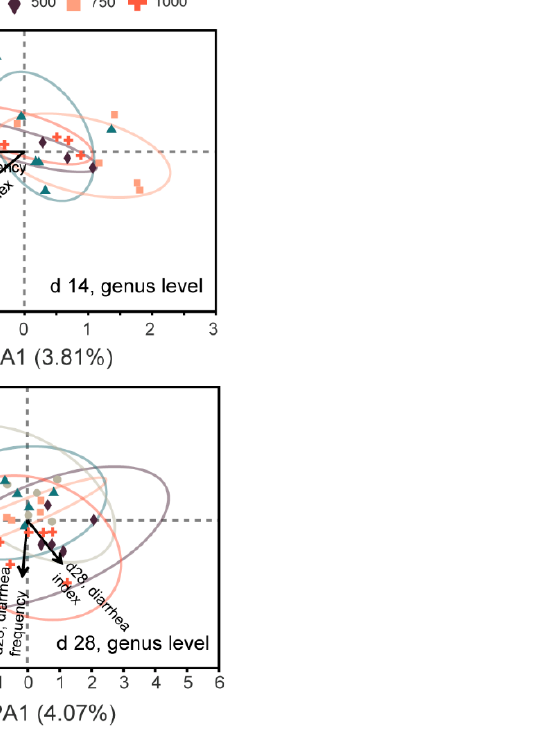
Figure 3. Distance - based redundancy analysis between microbiota and diarrhea incidence. A, d 14; B, d 28.